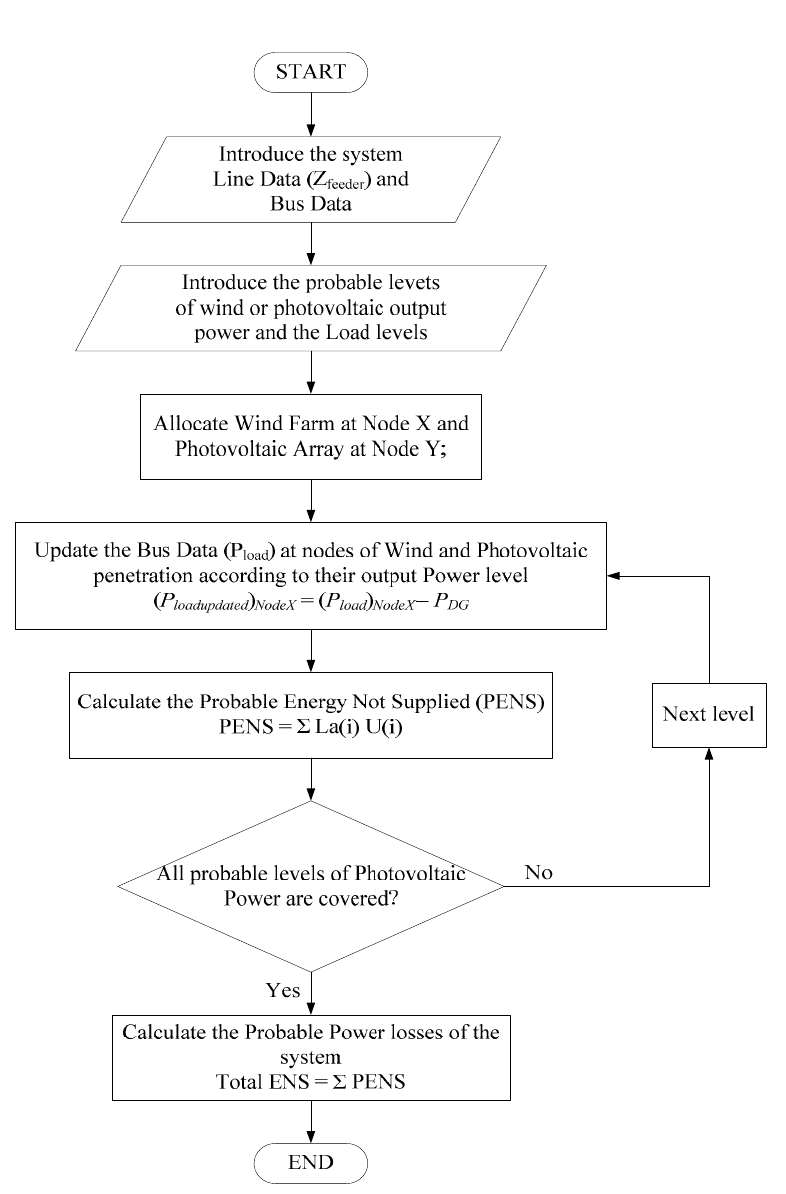
Figure 8. Flowchart for calculating Probable Energy Not Supplied ( PENS ) .